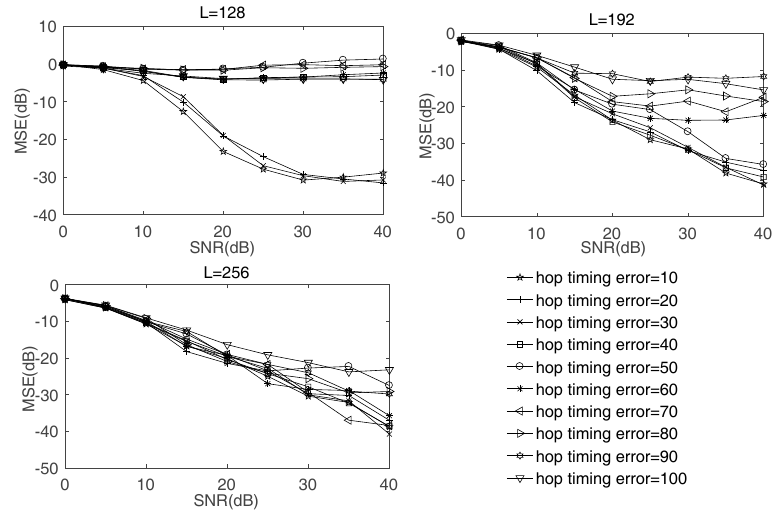
Figure 9. The impact of hop timing errors on the MSE of mixing matrix estimation.